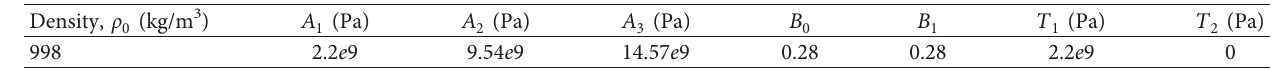
Table 6: Parameters of the water model.